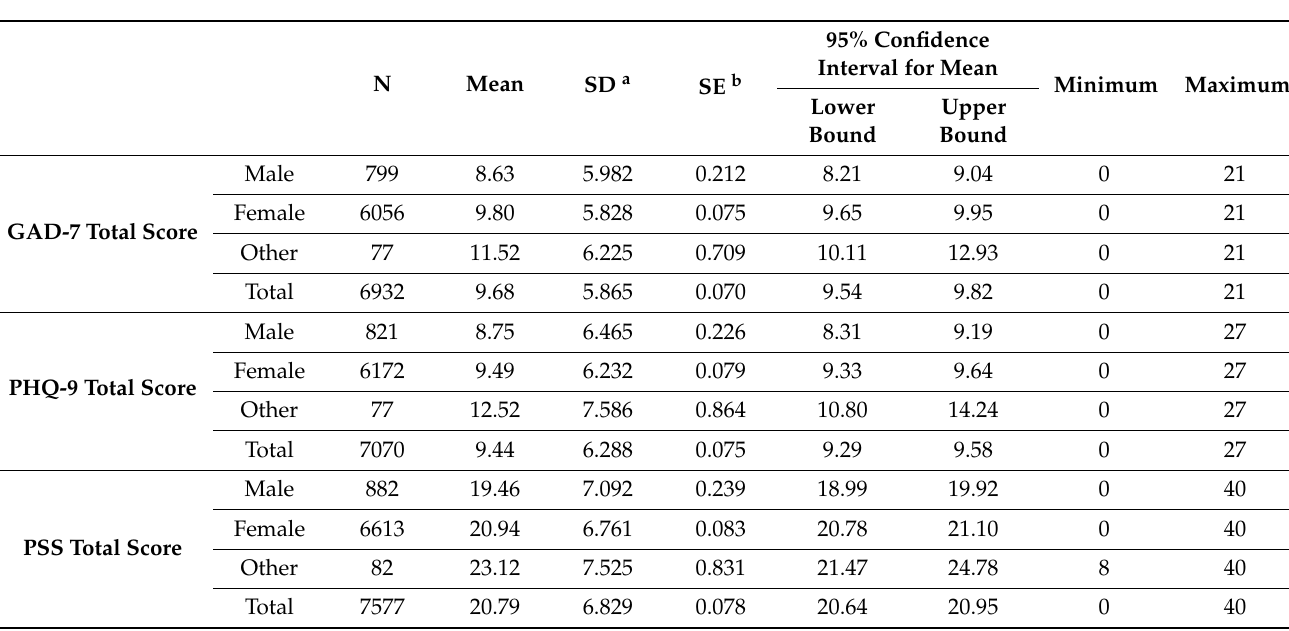
Table 3. Mean scores on the GAD-7 Scale, PHQ-9 Scale, and PSS by gender